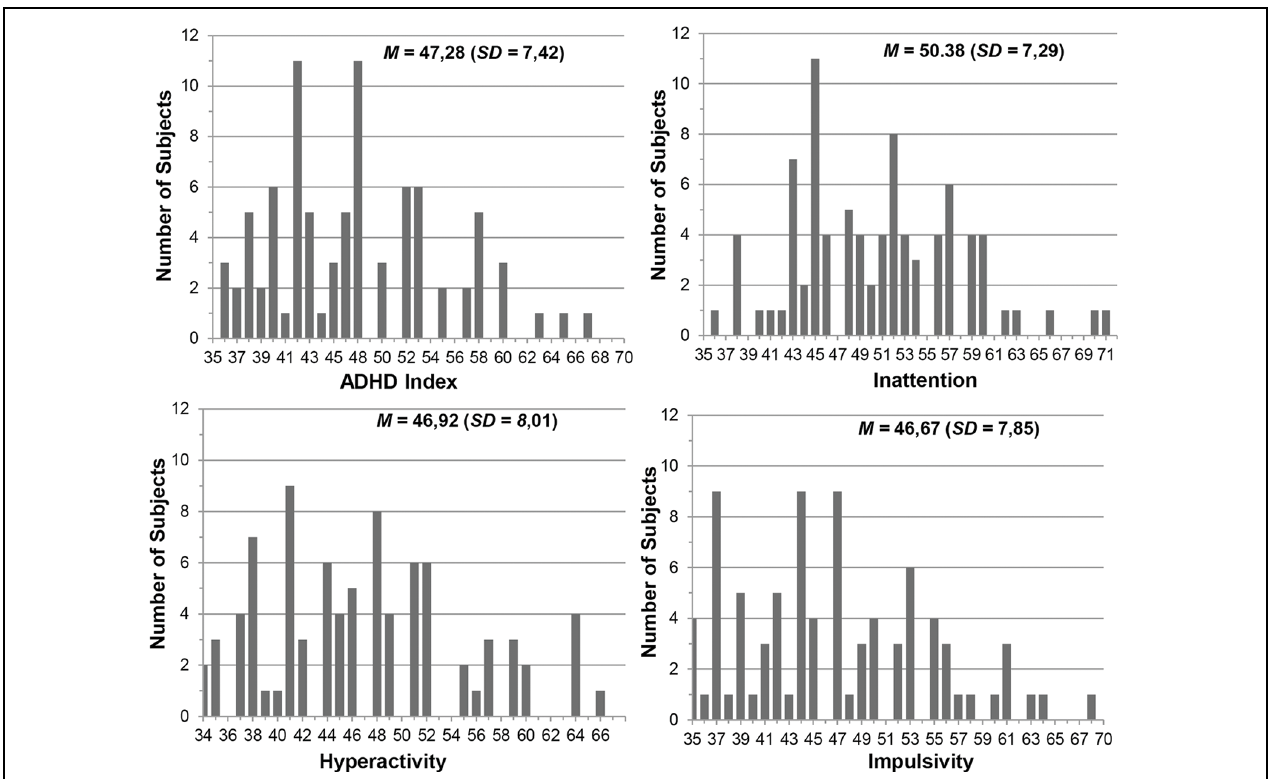
FIGURE 3 | The distribution of T -scores on the Conners’ Adult ADHD Rating Scales (CAARS) subscales of inattention, hyperactivity, impulsivity, and Attention-Deficit/Hyperactivity Disorder (ADHD) index.